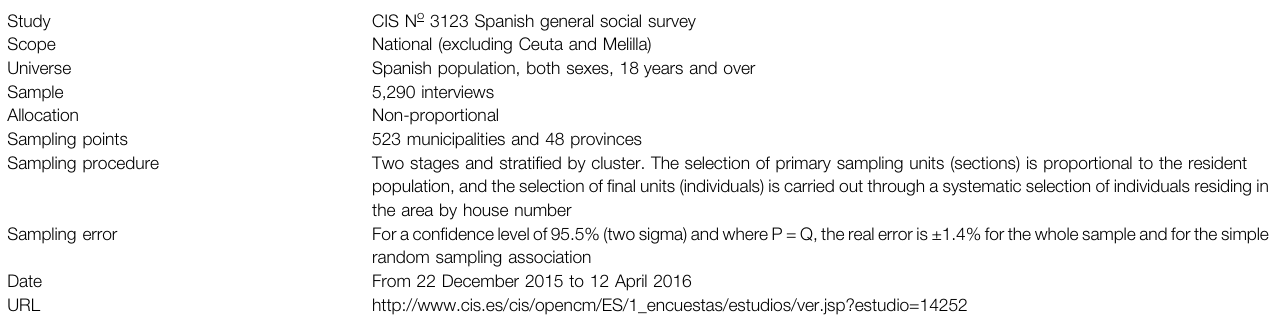
TABLE 1 | Factsheet of the survey. Study CIS N o 3123 Spanish general social survey Scope National (excluding Ceuta and Melilla) Universe Spanish population, both sexes, 18 years and over Sample 5,290 interviews Allocation